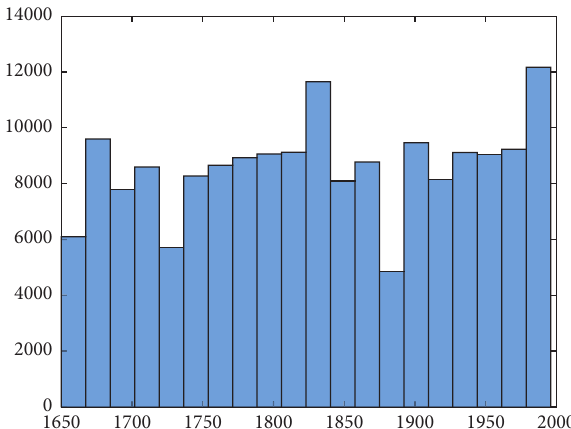
Figure 6: The statistical data of Young’s modulus.